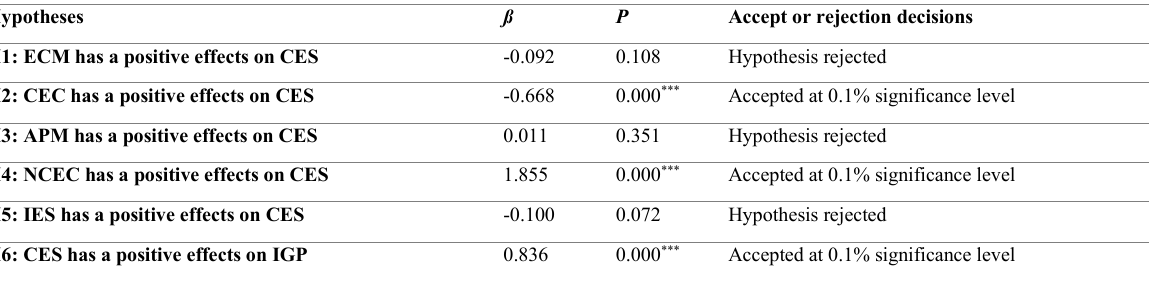
Table 5: Summary of the Hypotheses Tested